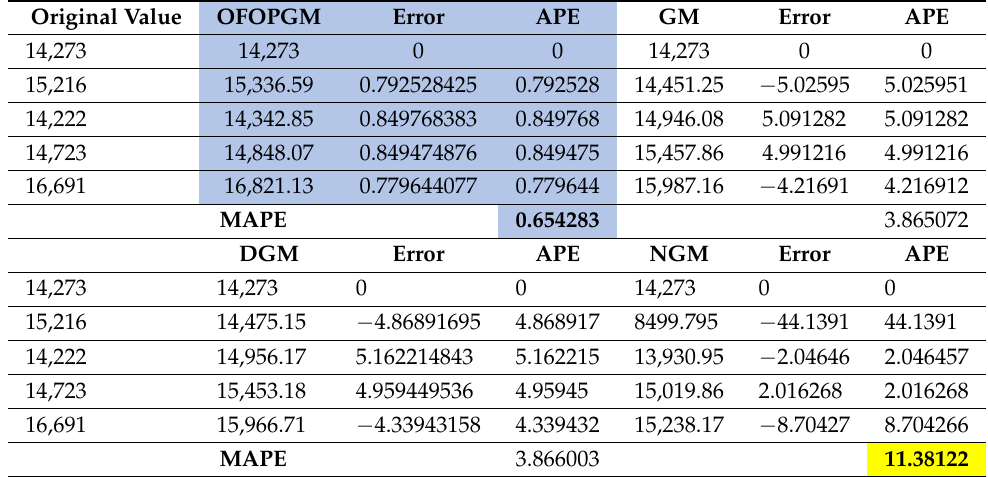
Table 1. CO 2 emission forecast [23].